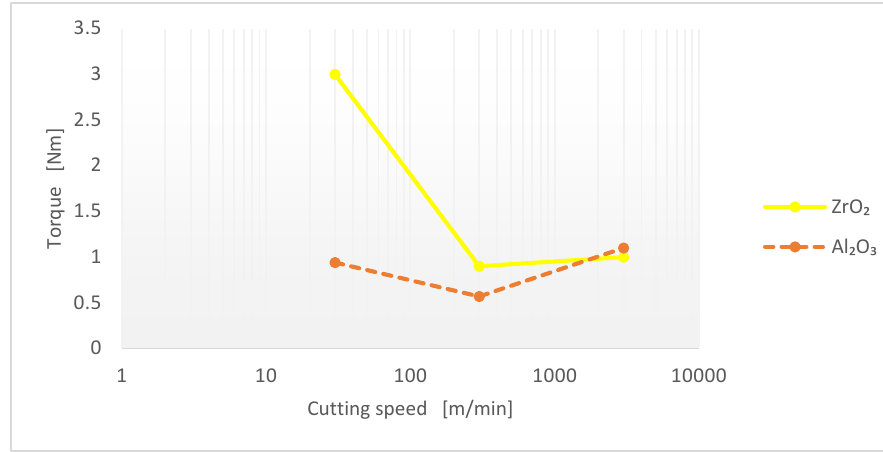
Figure 4. Influence of cutting speed on torque of the cutting tool.